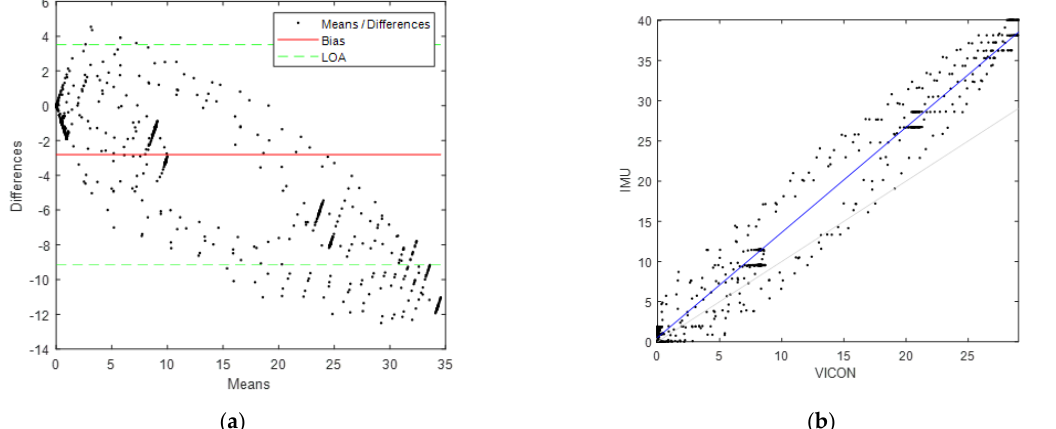
Figure 4. Angular velocity Bland-Altman plot between the IMU and VICON system. ( a ) The systematic bias (solid line) and the 95% limits of agreement (dashed line) are shown. ( b ) Linear regression (solid line) created by the individual comparison (star markers).